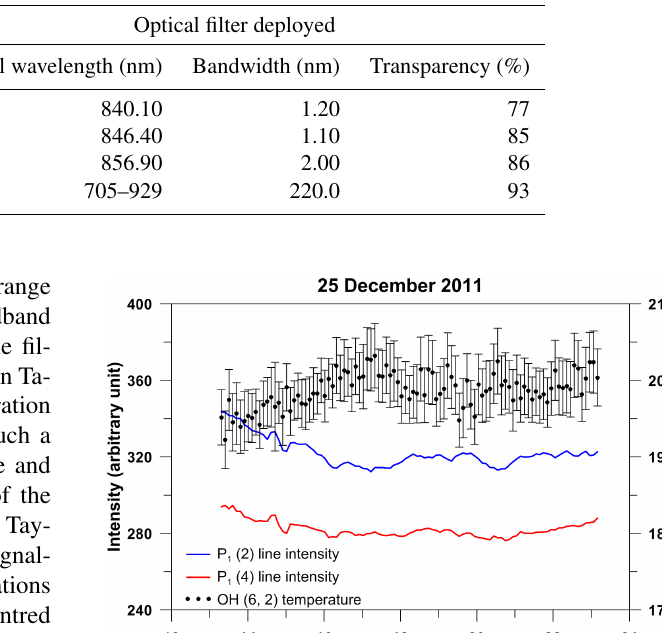
Table 1. Characteristics of optical filters used for OH nightglow observations at Ranchi.